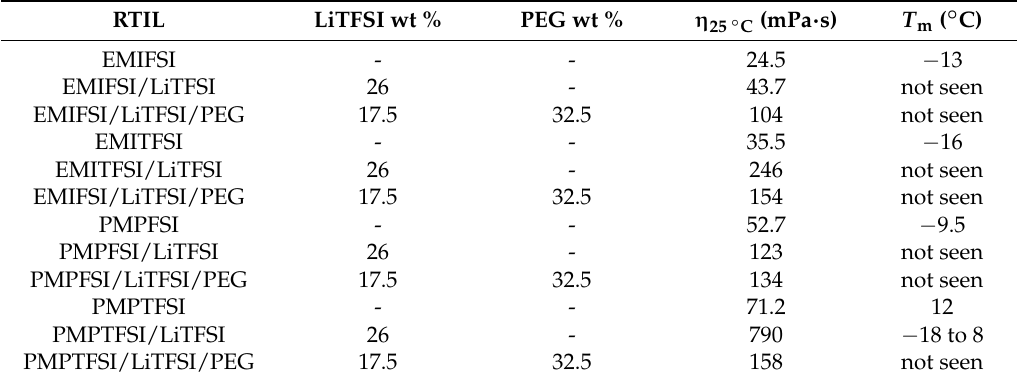
Table 3. Viscosity at 25 ◦ C ( η 25 ◦ C ) and melting temperature ( T m ) of the pure ionic liquids and of the solutions of LiTFSI in the ionic liquids employed (model liquid